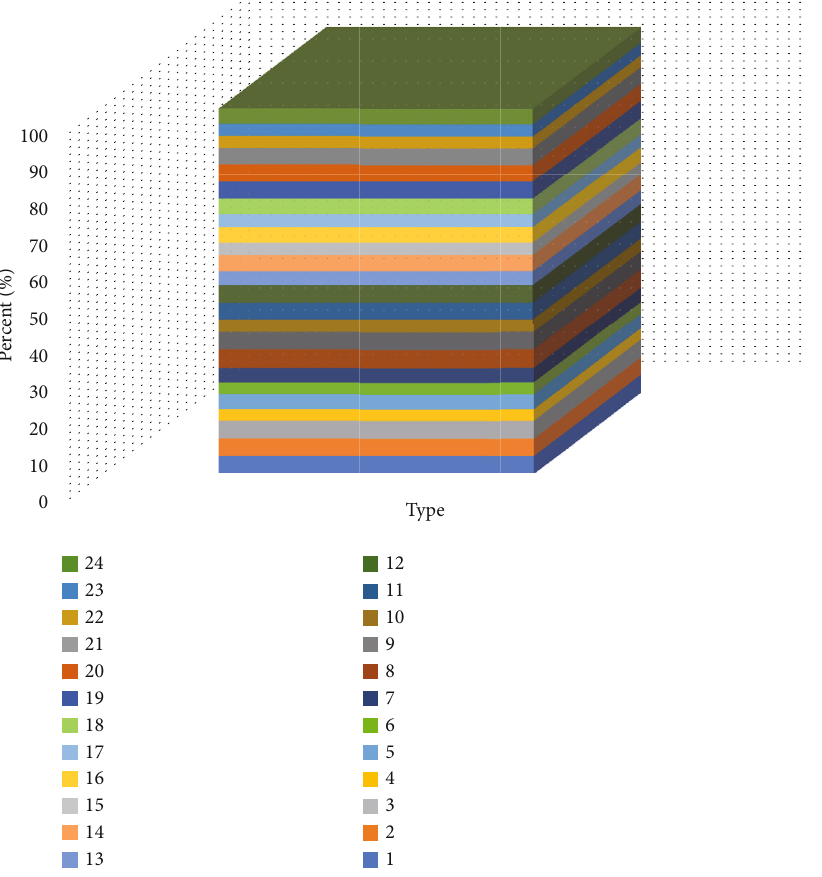
Figure 5: Rate of the emergence of play